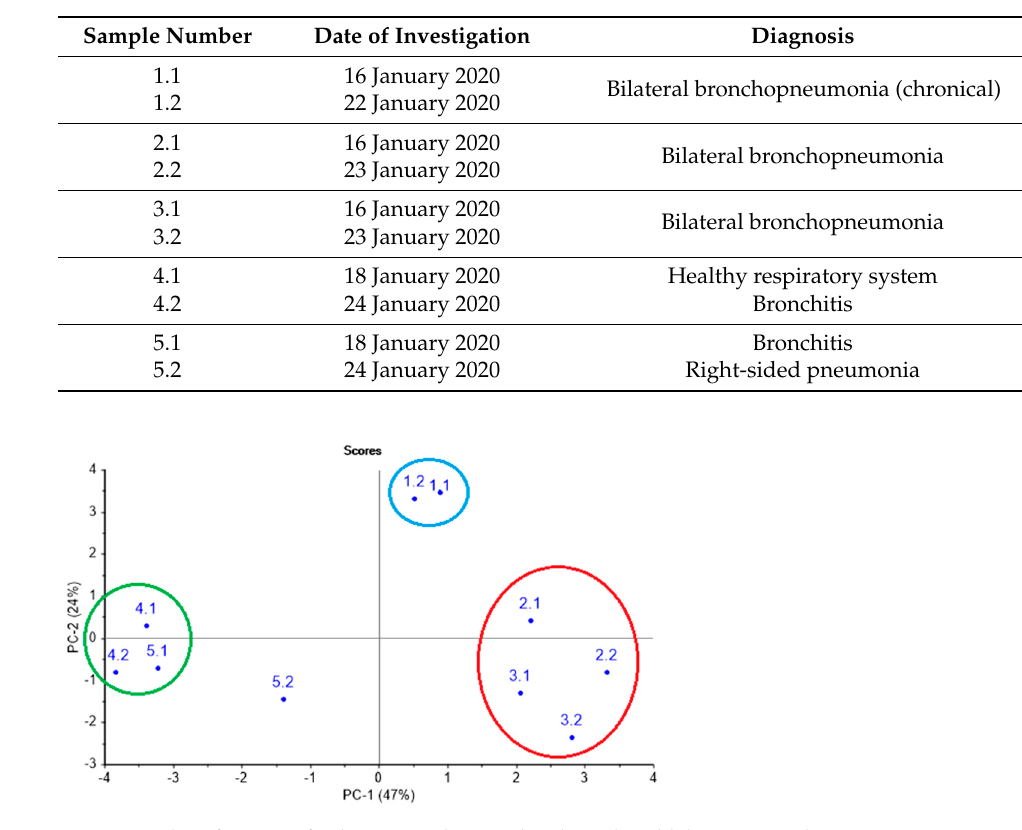
Table 2. The degree of damage to the respiratory system of calves according to the results of clinical and laboratory tests.